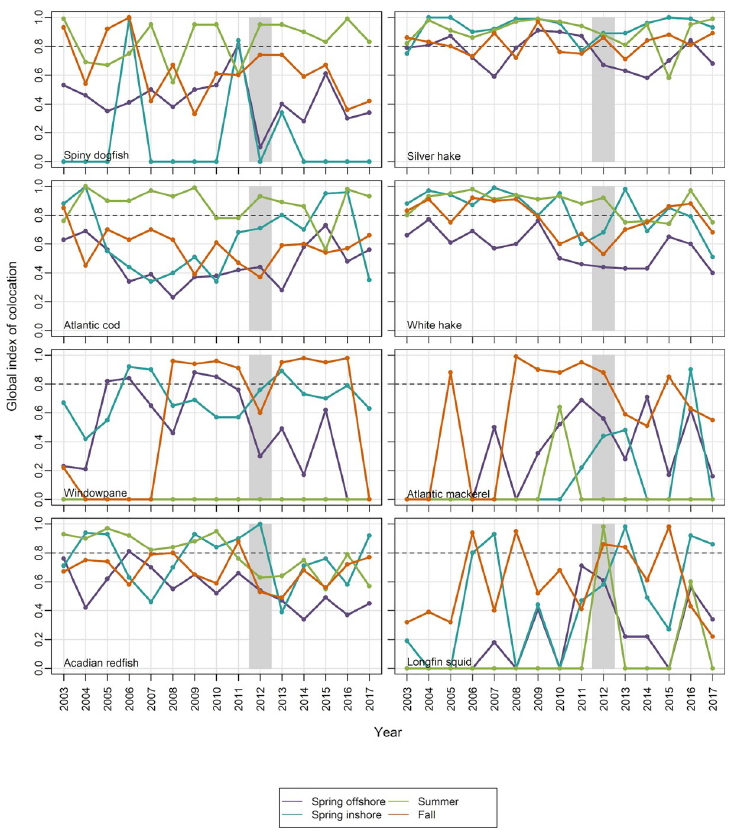
Fig 10. Global Index of Collocation (GIC) of 8 predators with northern shrimp. Values above the dashed line (GIC > 0.8) indicate high collocation. Shaded bar highlights 2012, when the shrimp decline became apparent.